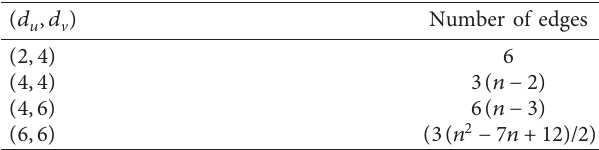
Figure 2: Triangular mesh T Table 3: The T n edge partition depends on the degree of the end vertices of each edge, where uv ∈ E ( G ) .